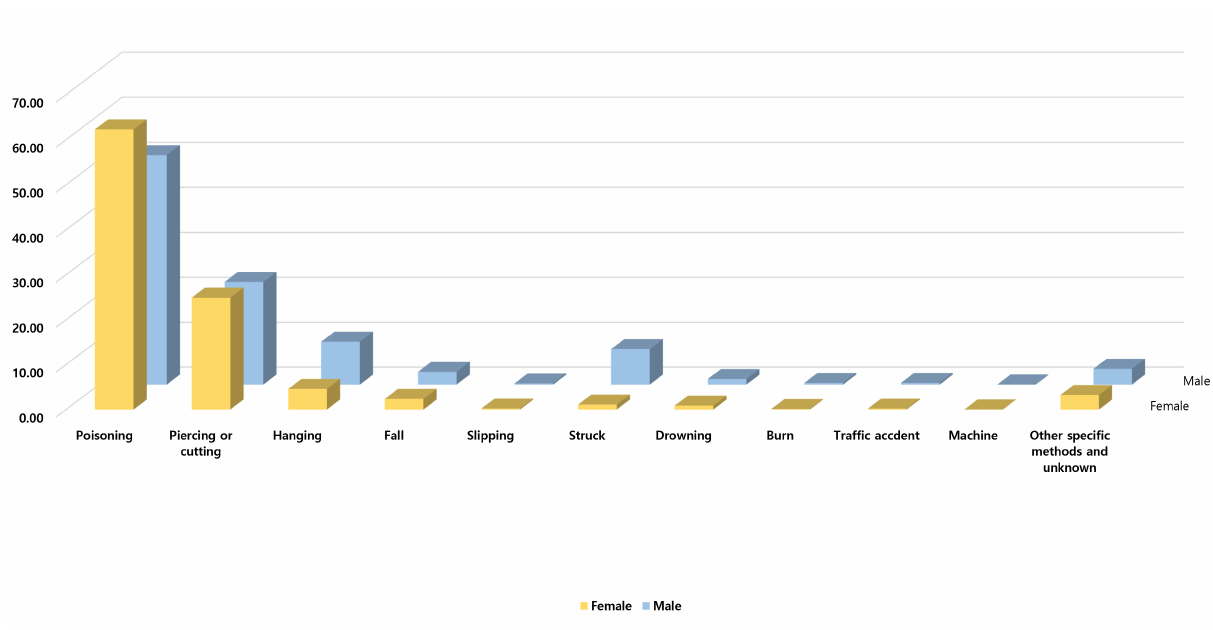
Fig. 3. Proportions of men and women in the study by each method of suicide.